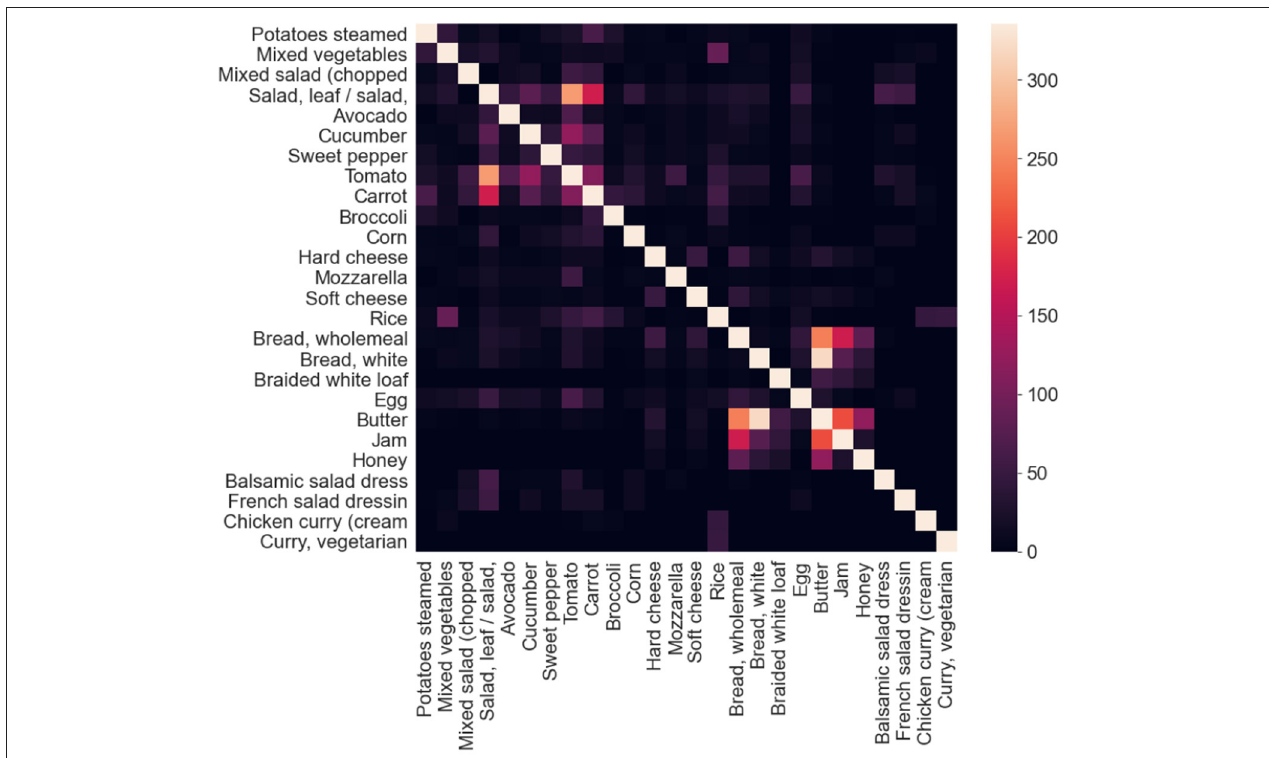
FIGURE 5 | Co-occurrence matrix of 26 food classes which have a co-occurrence of more than 40 instances across the publicly available dataset. When computing the co-occurrence matrix, the self co-occurrence values were not considered, and for illustration purposes, it has been artificially set to a value slightly above the maximum co-occurrence values across all the classes in consideration.